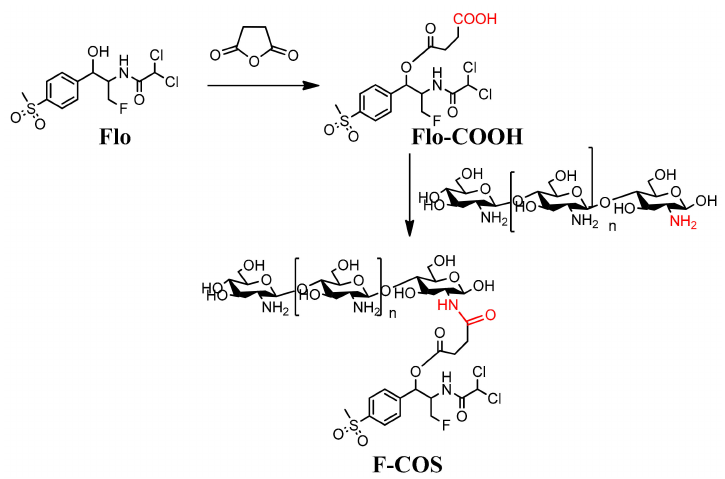
Figure 1. Synthetic routes of Florfenicol-COS conjugates (F-COS). The red color represented the carboxylic acid group of FCOOH condensated with the amino group of COS to form the product